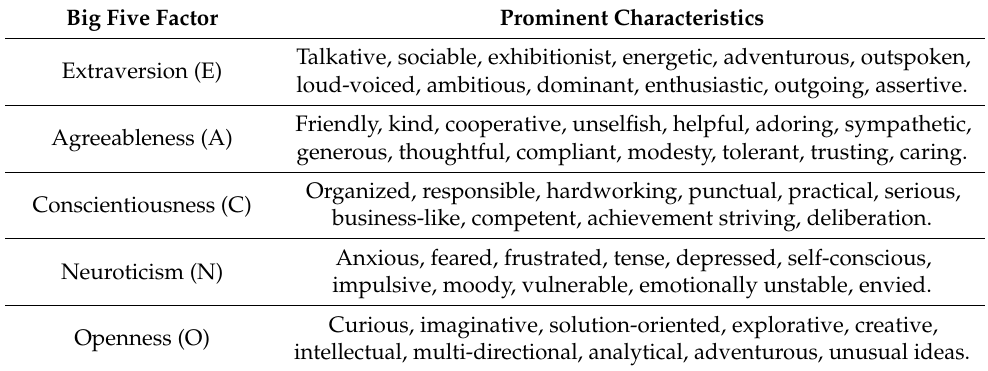
Table 2. Characteristics of big five